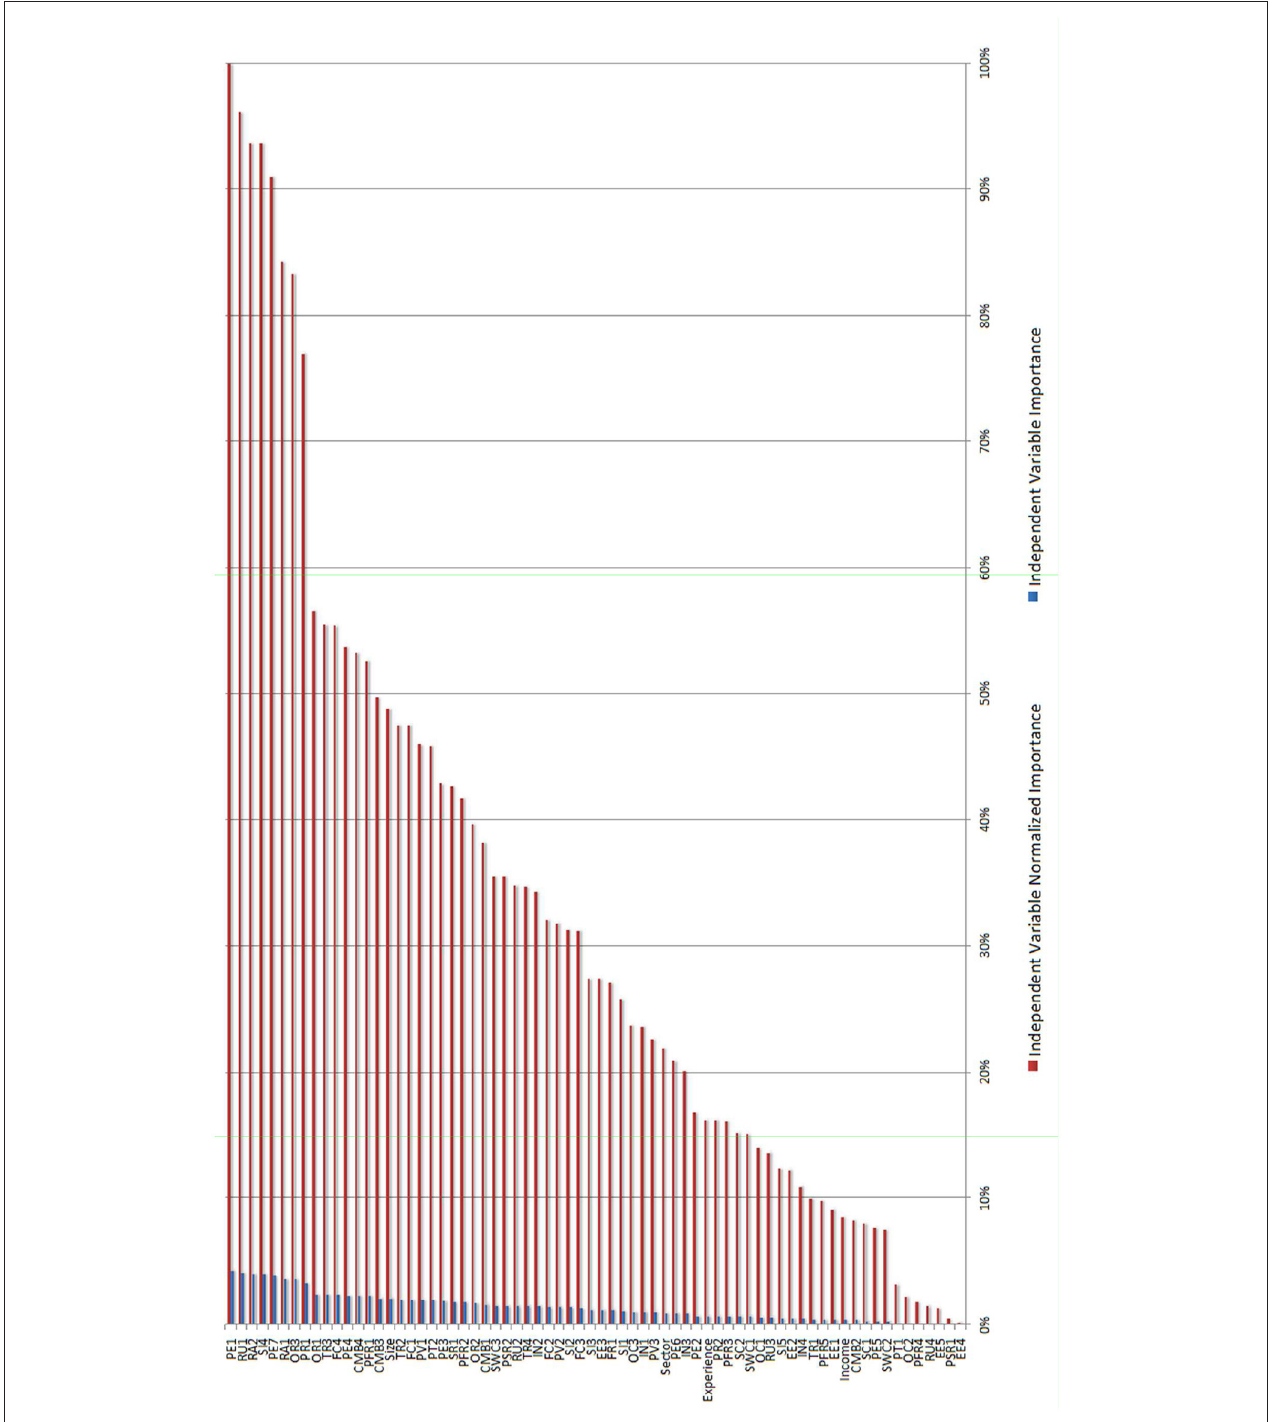
FIGURE 4 | Normalized importance of the variables in